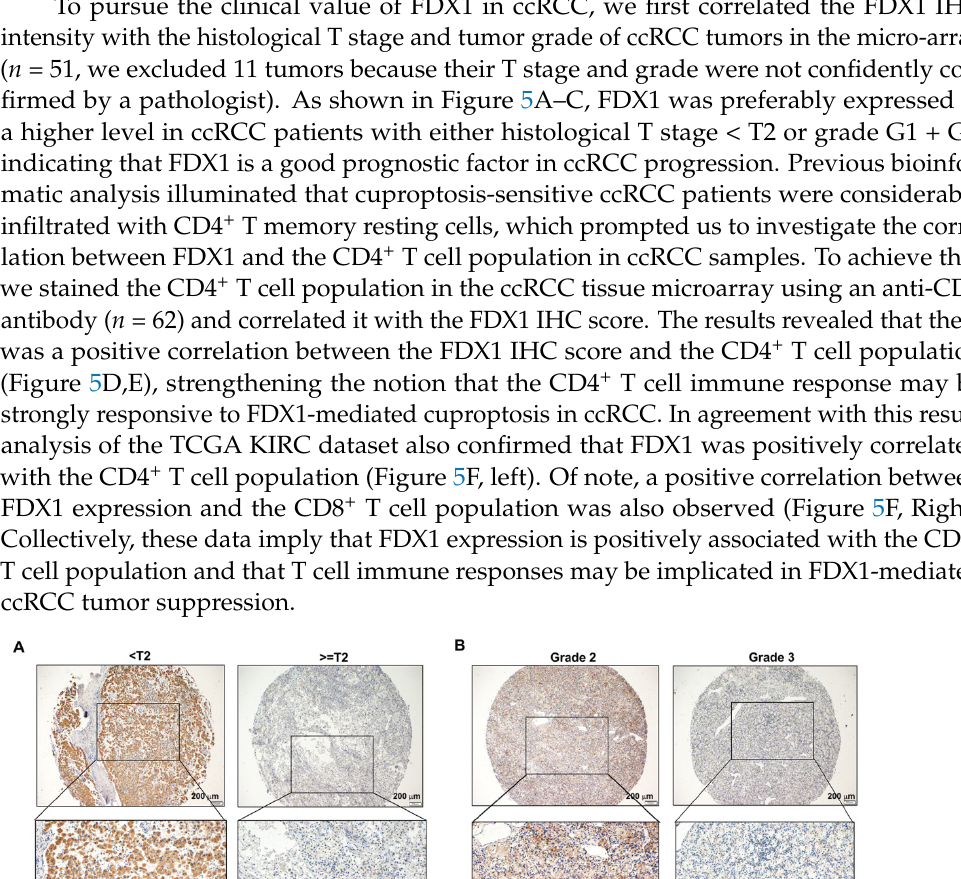
Figure 5. FDX1 correlates with the infiltration of CD4 + T cells in ccRCC . ( A ) Representative IHC images of FDX1 in different histological T stages of ccRCC. Scale bar: 200 μ m for the top images and